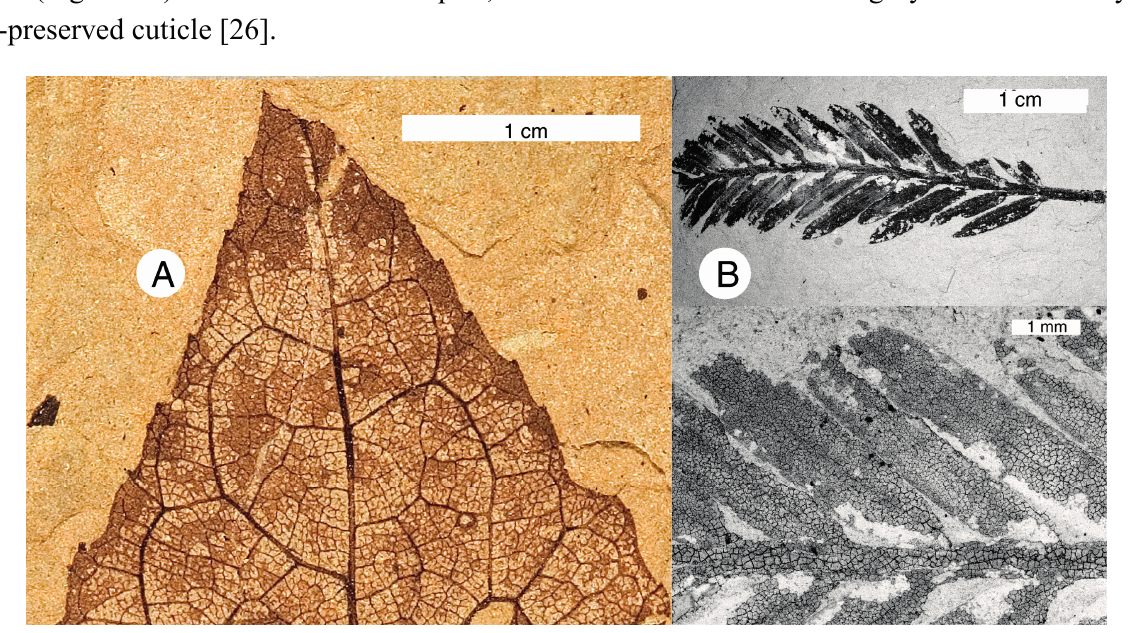
Figure 13. Leaf compressions from middle unit mudstone preserving relict carbonized tissue: ( A ) unidentified dicot (WWU SR-02-2714B) with thin cuticle layer; and ( B ) SEM Backscattered electron image of Metasequoia occidentalis , WWU specimen, showing thick, fragmented carbonized